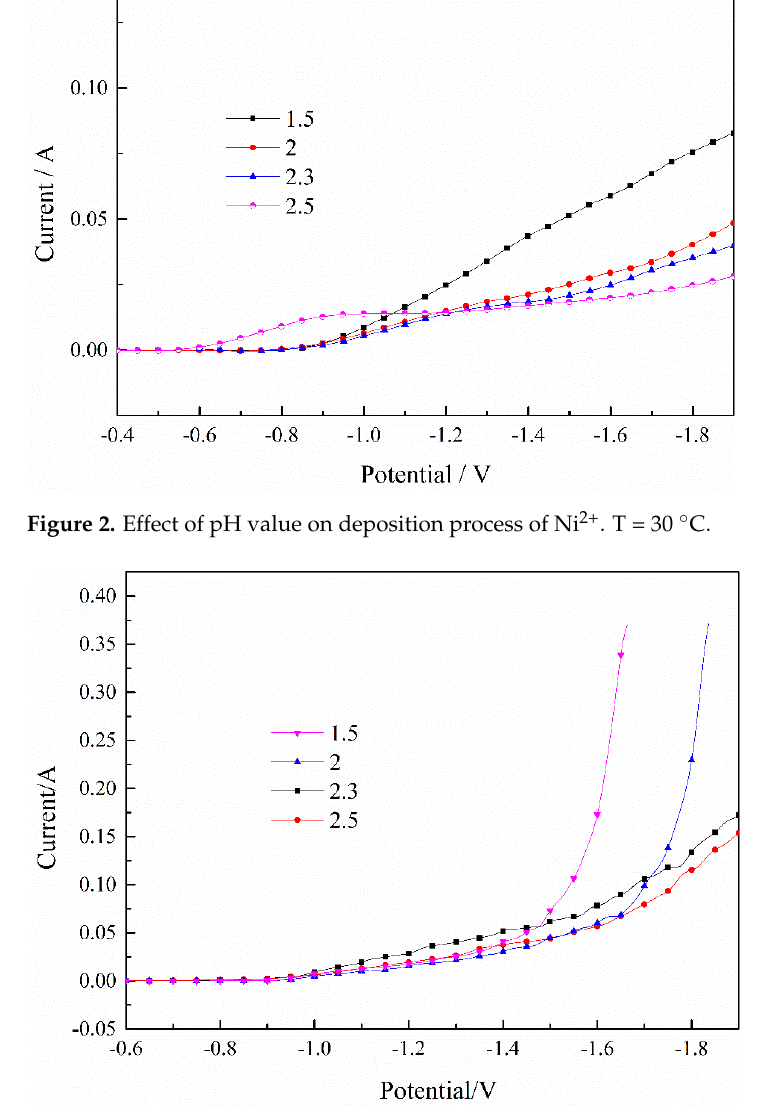
Figure 2. Effect of pH value on deposition process of Ni 2+ . T = 30 °C.